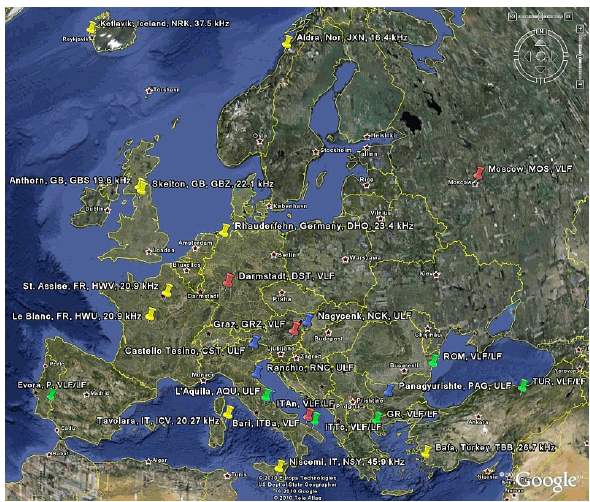
Fig. 1. Station network for combined investigations of local and mesoscale geophysical/seismic phenomena, consisting of (i) VLF only (red markers), (ii) VLF/LF (green), (iii) South European Ge- omagnetic Array (SEGMA) ULF (blue) receiving stations, and (iv) European VLF transmitters (yellow), LF transmitters not shown – Google Earth map.